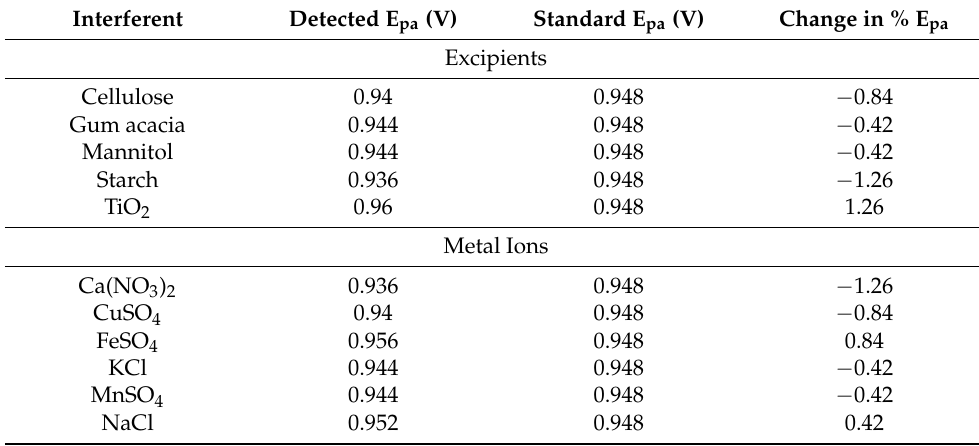
Table 3. Details of interference response of PMXL at gCN · CPE.